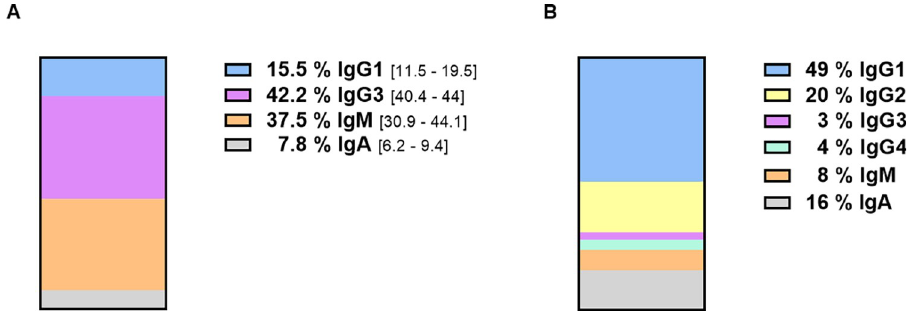
Fig 4. Comparison of neutralization capacity against total Ig mass. (A) Contribution of Ig classes to the neutralization of SARS-CoV-2 (percentage contribution) based on experimental data depicted in Table 1. (B) The abundance of Ig classes as percentage of total Ig in convalescent plasma pool are based on quantitative nephelometric results.